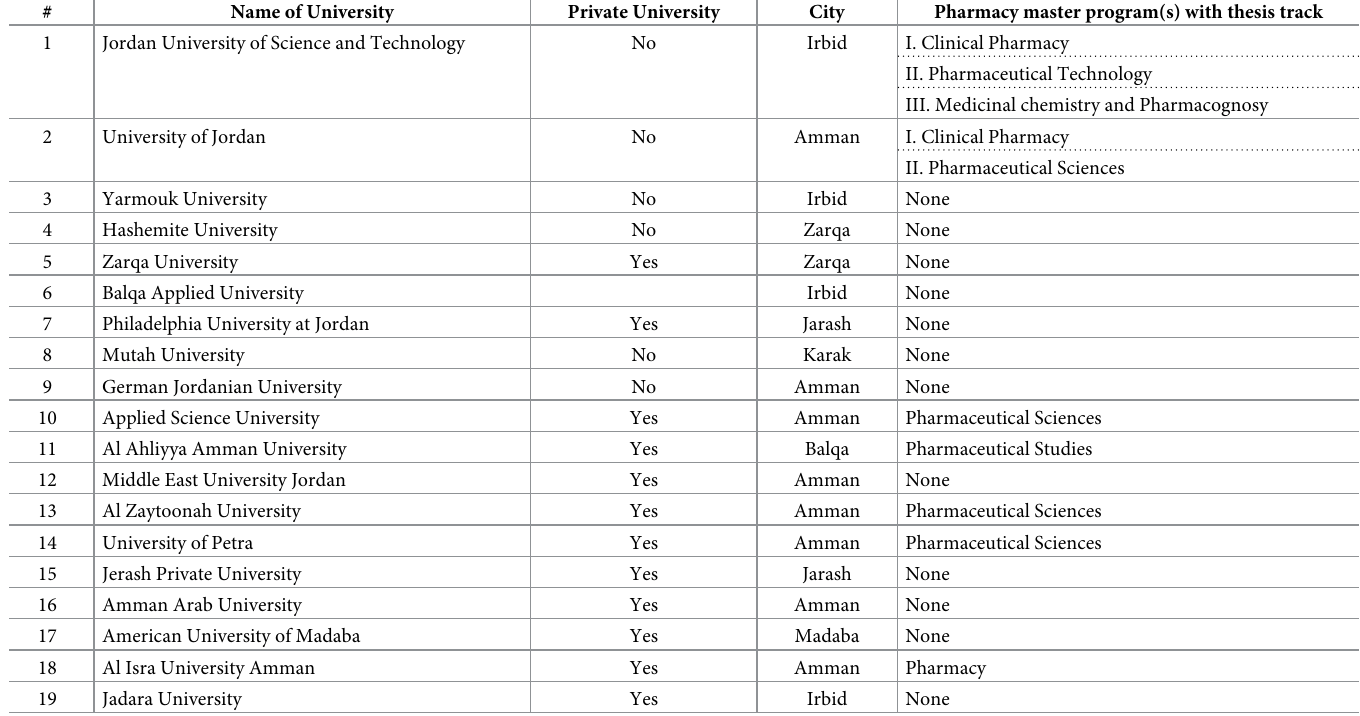
Table 2. List of Universities with pharmacy schools/departments in